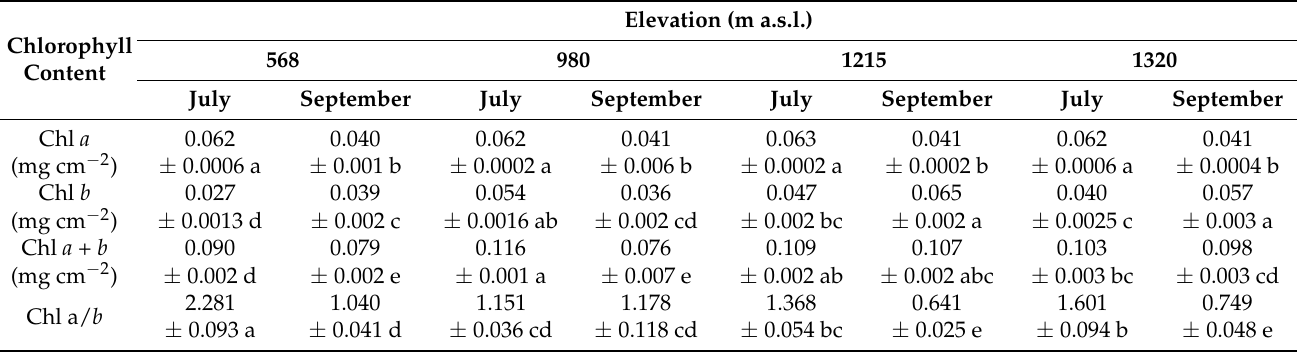
Table 2. Chlorophyll content in the leaves of green alder (Alnus viridis ) collected in July and September from plants growing in the Bieszczady Mts. at various elevations a.s.l.